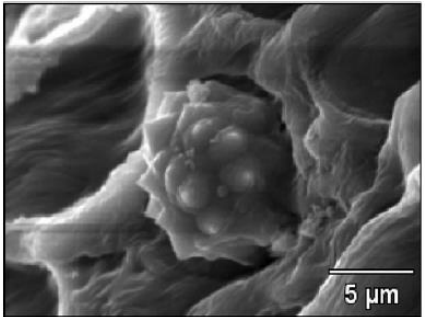
Figure 3. Energy Dispersive Spectroscopy (EDS) of OPMF [6].